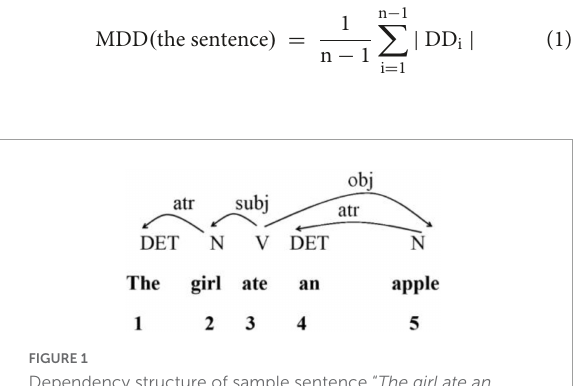
FIGURE1 Dependency structure of sample sentence “ The girl ate an apple” (Liang et al.,